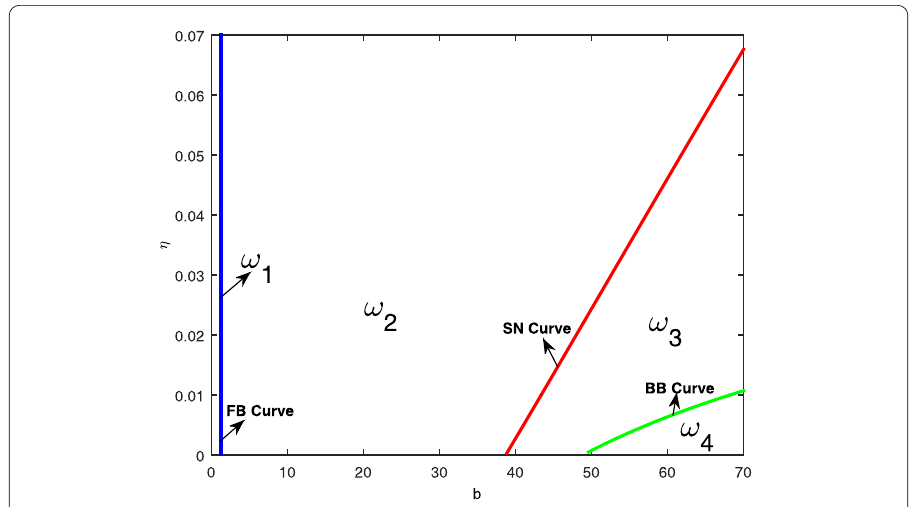
Figure 4 Two parameter bifurcation diagram of b and η . ‘SN’ represents saddle-node bifurcation, ‘BB’ means backward bifurcation and ‘FB’ is for forward bifurcation. The other parameter values are the same as those in